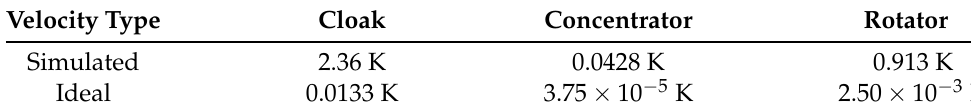
Table 1. Average temperature deviation in the background when h / L = 0.1.